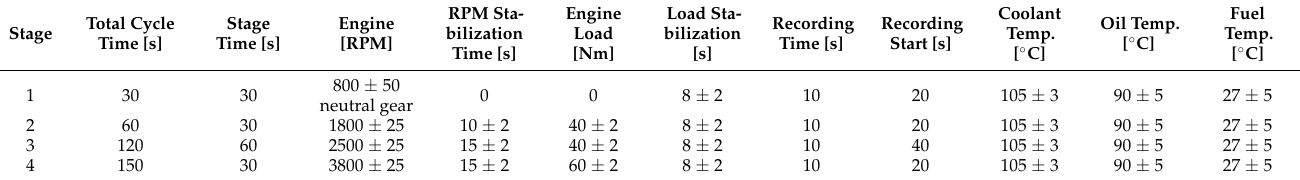
Table 4. Parameters and requirements of the 4-stage test cycle of the FORD FlexFuel